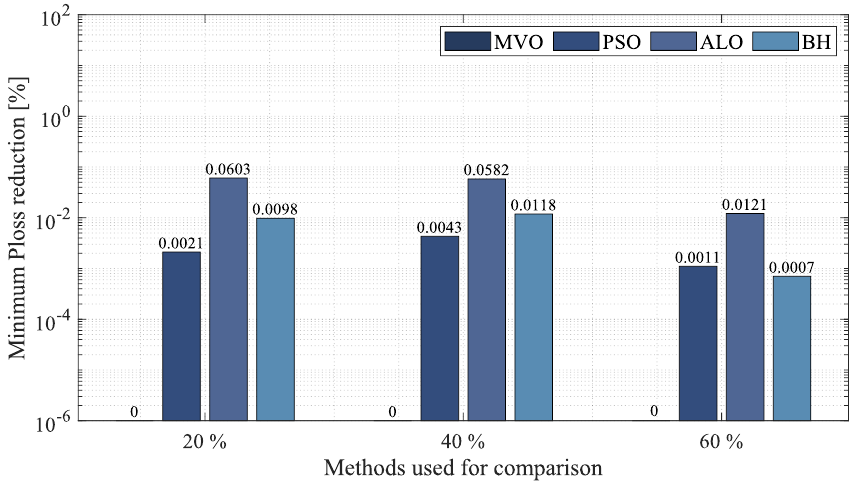
Figure 9. Percentage of reduction of minimum power losses obtained by the MVO in the 33-node radial test system compared to other